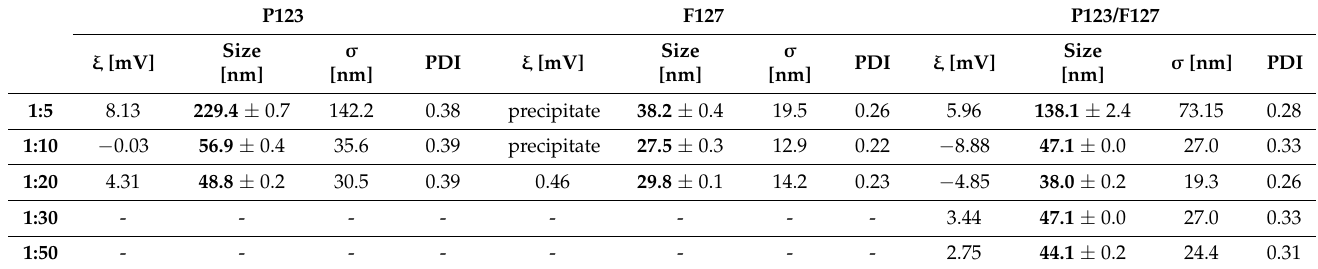
Table 3. Size of the naringenin-loaded polymeric micelles dissolved in water. ξ —Zeta potential, σ —standard deviation, PDI—polydispersity index.